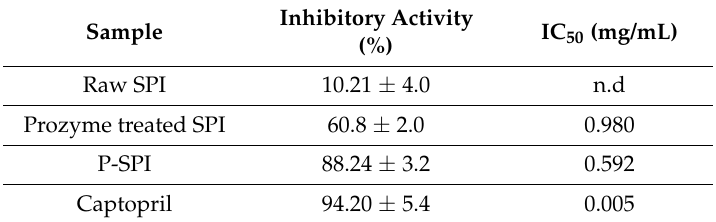
Table 1. Angiotensin-converting enzyme (ACE) inhibitory activity of processed SPI